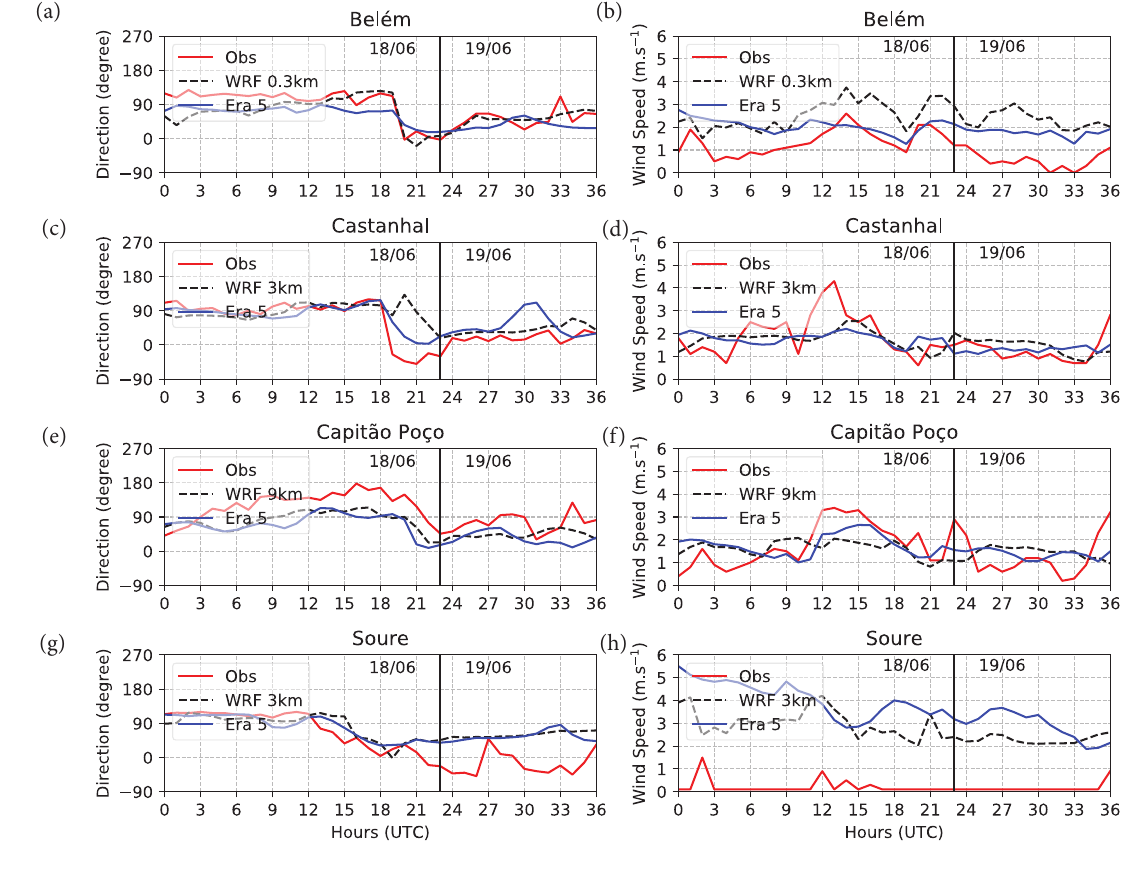
Figure 5. Wind direction and speed at 10 m for Belém (a and b), Castanhal (c and d), Capitão Poço (e and f), and Soure (g and h), respectively, from June 18 th , 2011 to June 19 th , 2011 (19 th going from 24 to 36 UTC). The solid line separates the two